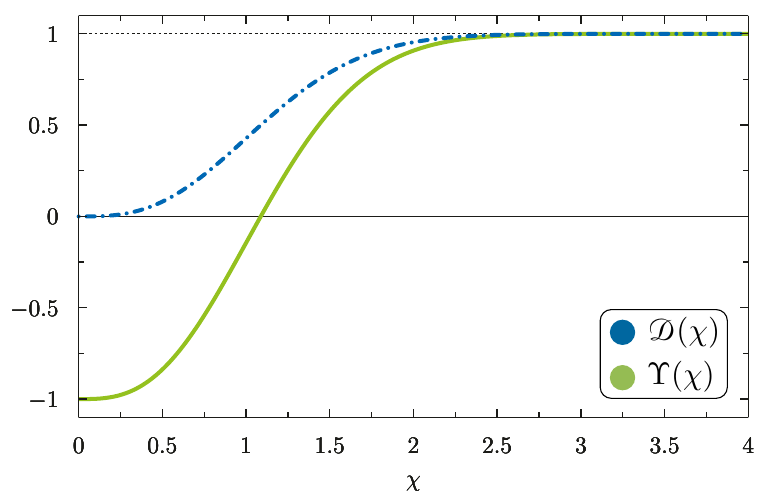
Figure 2. The droplet profiles D ( χ ) and Υ( χ )